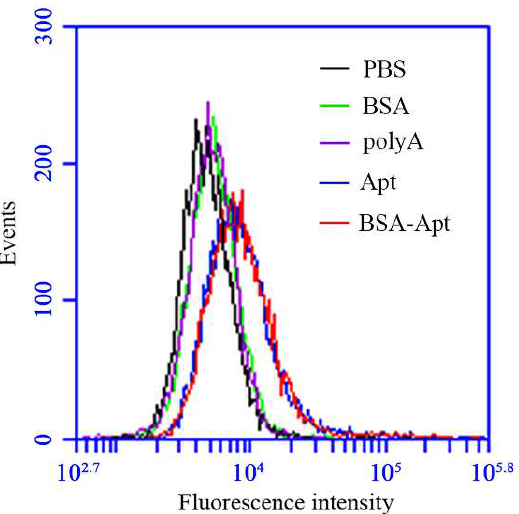
Figure 4. The bindings of BSA, polyA, free PD-L1 aptamer, or BSA-Apt to PDL1-positive CT26 cells. CT26 cells (2 × 10 5 ) were incubated with 60 pmol of FAM-labeled BSA (green), polyA (purple), free PD-L1 aptamer (blue), or BSA-Apt (red), respectively. The cells were washed with PBS and analyzed by flow cytometry.